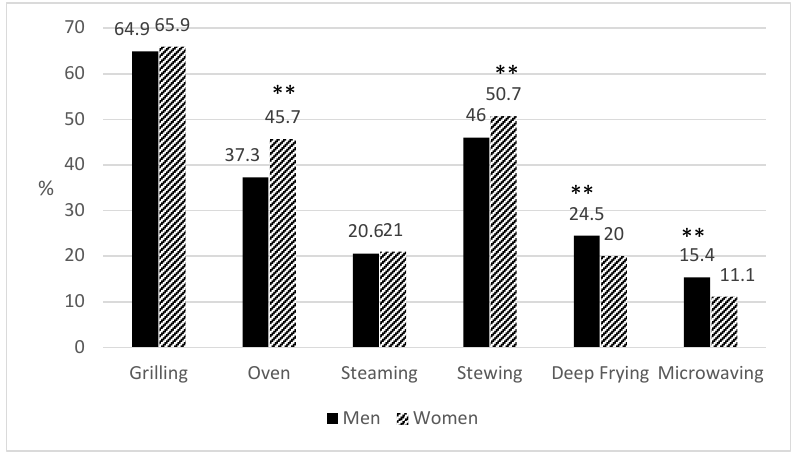
Figure 4. Preferred cooking techniques. Sample sizes by gender: n = 792 men; n = 1219 women. ** p < 0.01, women vs. men.